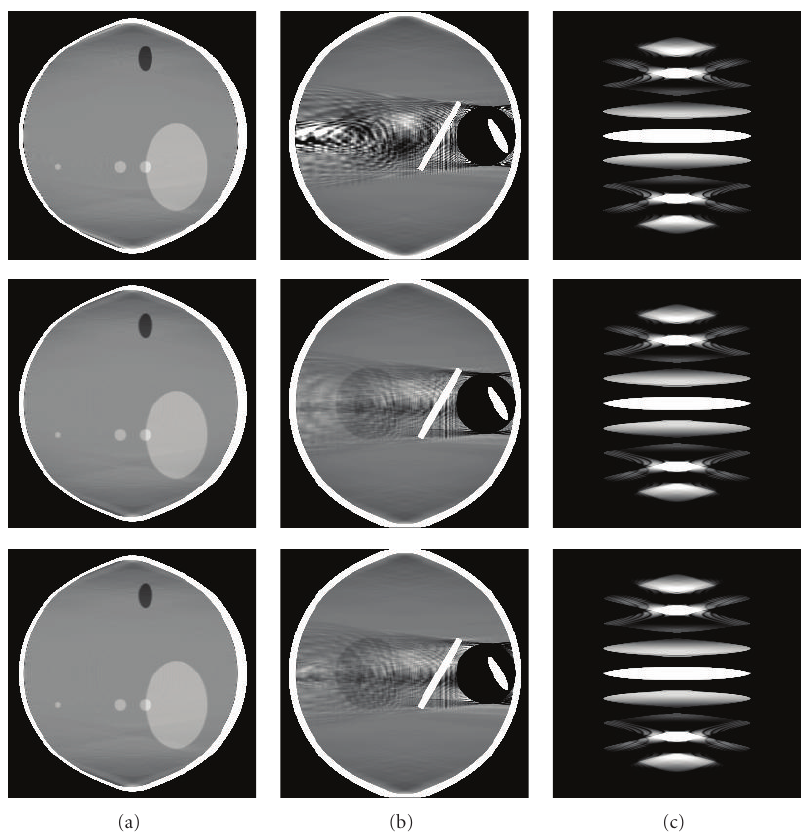
Figure 10: From left to right column, reconstructed slices of the Shepp-Logan low contrast, ForBild head and Defrise disk phantom, respectively, at x = 0. From top row to bottom row, reconstruction with Zhu et al.’s algorithm, EM-1 (CFDKW-1 + FN), and EM-2 (CFDKW-2 + FN), respectively. Display windows are [0 . 98 1 . 05], [1 . 01 1 . 09] and [0 . 5 0 . 7] for Shepp-Logan, ForBild head, and Defrise disk phantom,